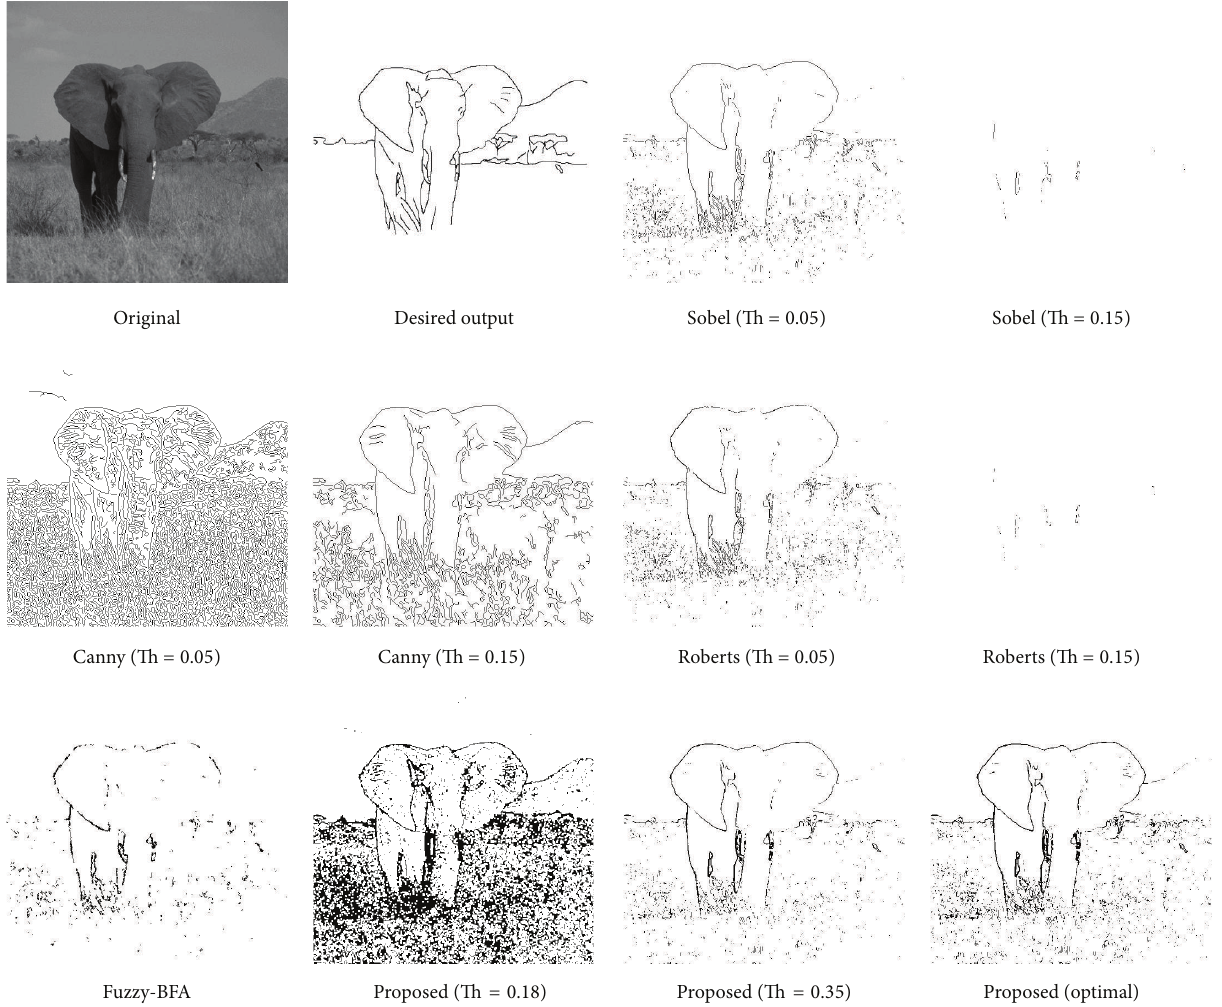
Figure 7: Edge detection results of “elephant” image: desired edge output of “elephant” image; Sobel, Canny’s, and Roberts methods using thresholds = 0.05 and 0.15; fuzzy-BFA method; proposed method with fixed thresholds (0.18 and 0.35) and optimal